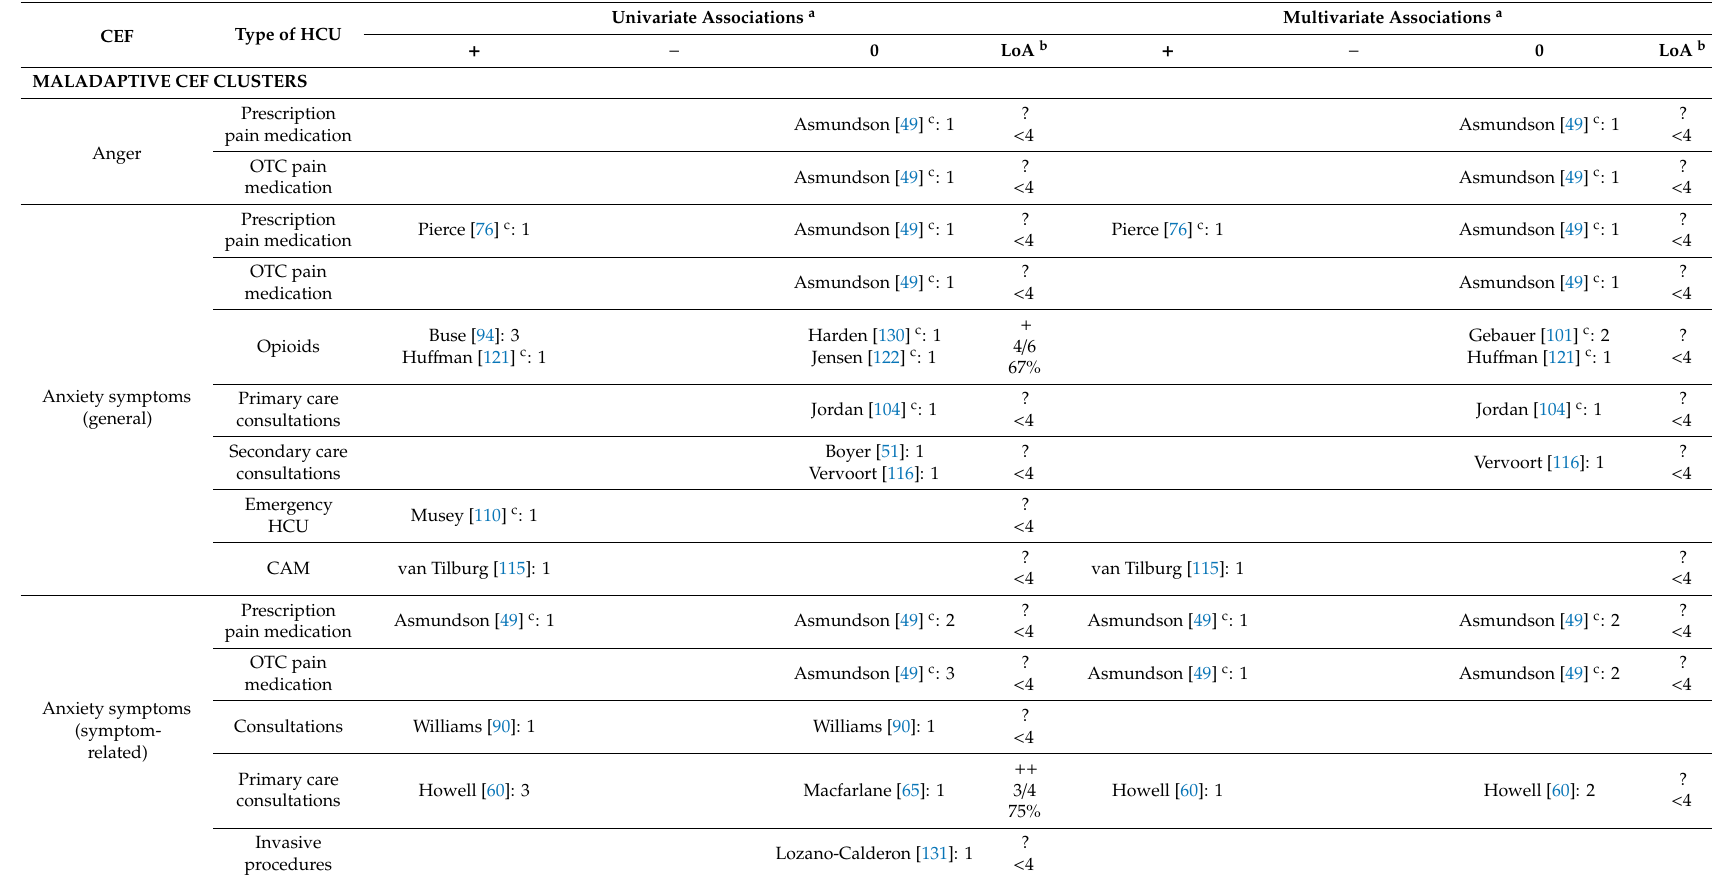
Table A5. Associations between type of HCU (presence or absence of a certain type of HCU) and CEF in people experiencing pain. Univariate Associations a Multivariate Associations a CEF Type of HCU + − 0 LoA b + − 0 LoA